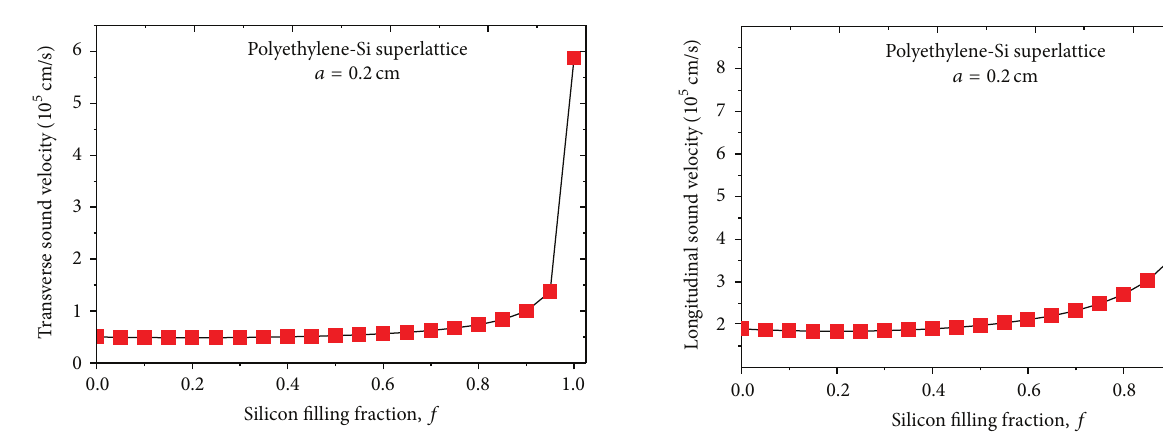
Figure 4: Effective sound velocity for longitudinal vibrational modes propagating along the growth direction of a Polyethylene-Si superlattice.Here, solid line was obtained by using formula (33) and squares were obtained by using formula (36).